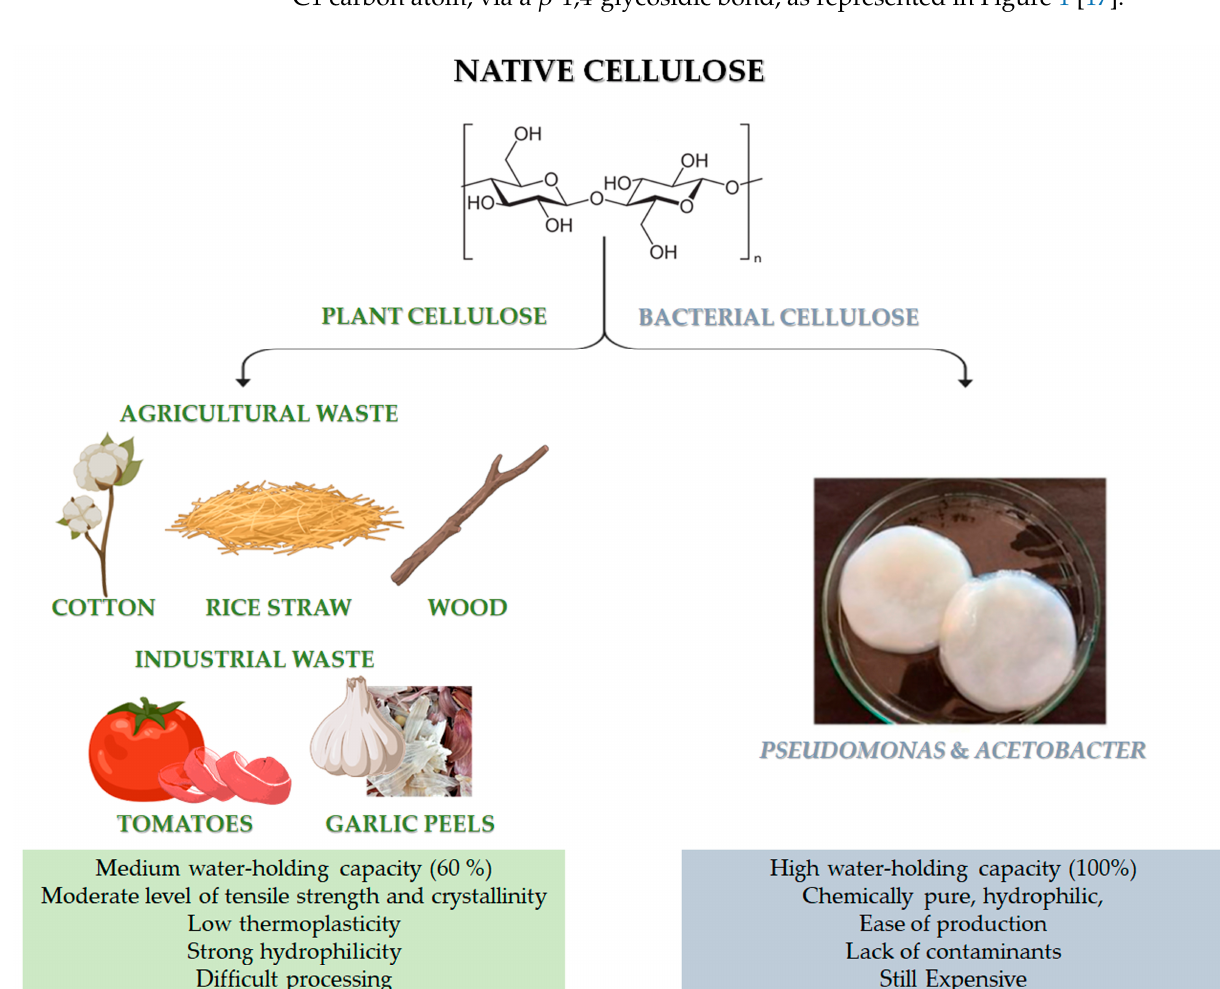
Figure 1. Chemical structure of cellulose and different sources of: native cellulose (from agricultural and industrial wastes) and bacterial cellulose (BC). Advantages and disadvantages of both kinds of cellulose. The image of BC is adapted from [18]. Copyright 2022 by the authors. License MDPI, Basel, Switzerland.